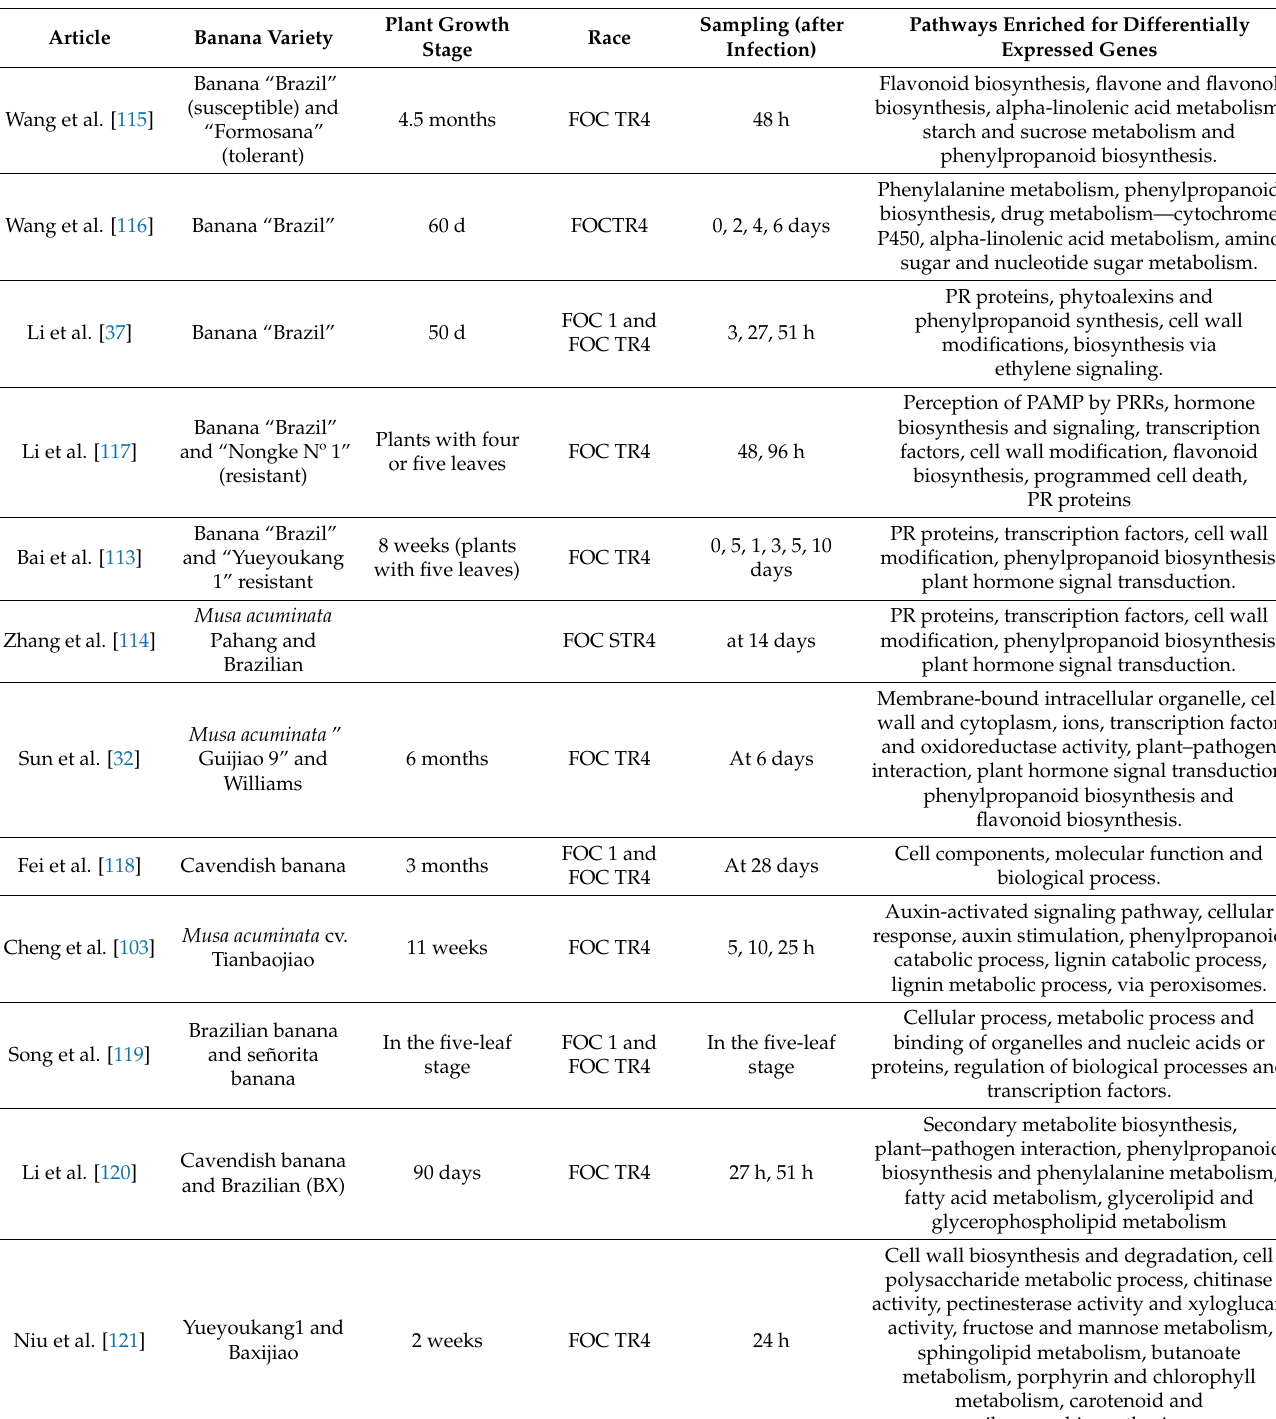
Table 5. Transcriptomic studies involving banana plants infected with Fusarium oxysporum f. sp. cubense in articles about the improvement of banana to Fusarium wilt, carried out in the last ten years